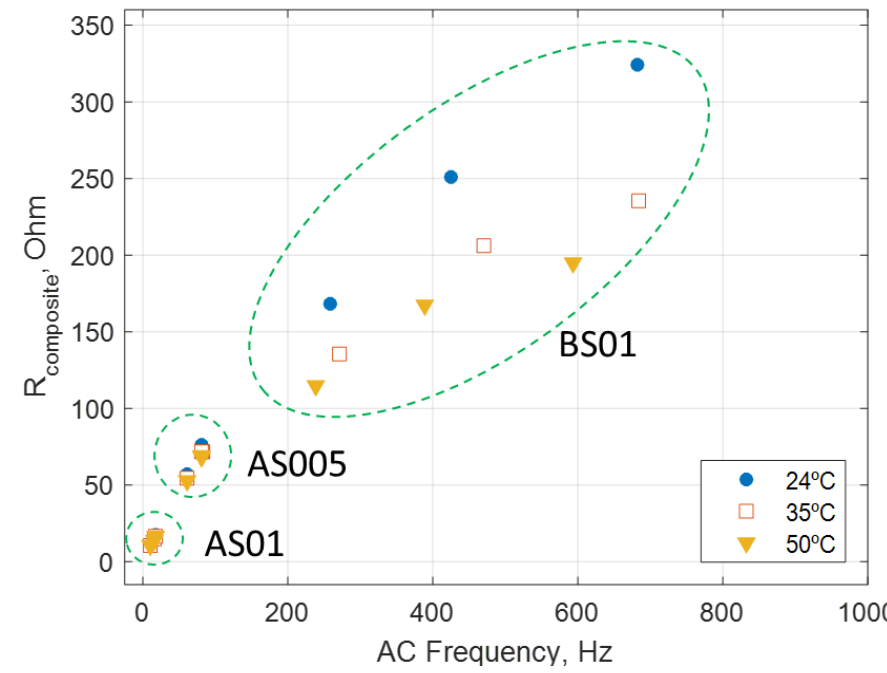
Figure 6. Cusp values (AC frequency and R composite ) for mortars AS01, AS005, and BS01. One point per sample and at different temperatures are shown.